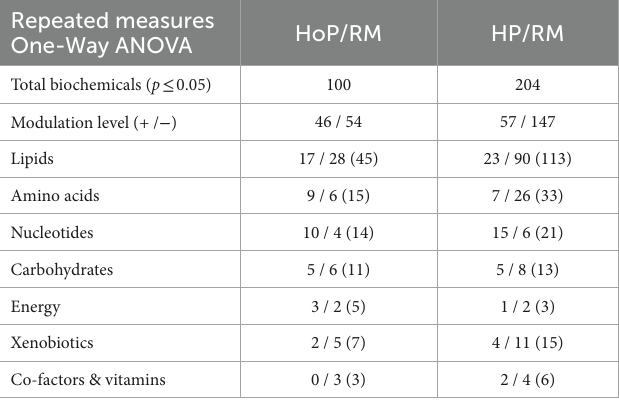
TABLE 1 Main biochemical class assigned to the identified metabolites that achieved statistical significance ( p ≤ 0.05) differences between groups in pooled DM samples of cohort